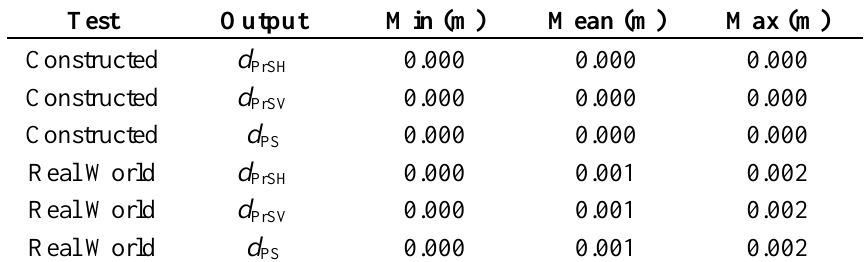
Table 5. Error summary of point and profile tests using constructed CAD models and point cloud data from two real world MMSs.